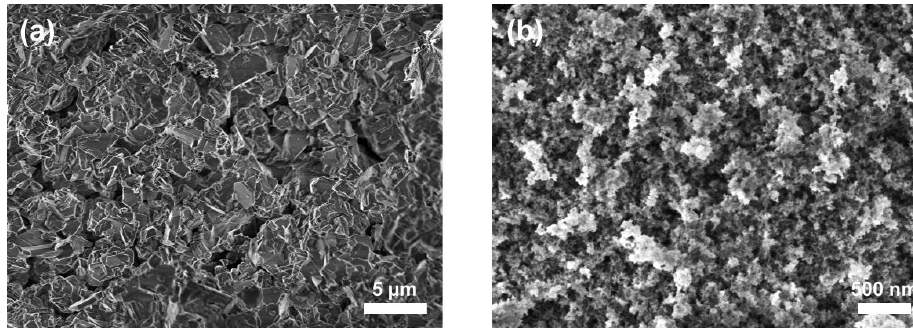
Figure 8. SEM micrographs of ( a ) Sialon and ( b ) Alu C fillers.